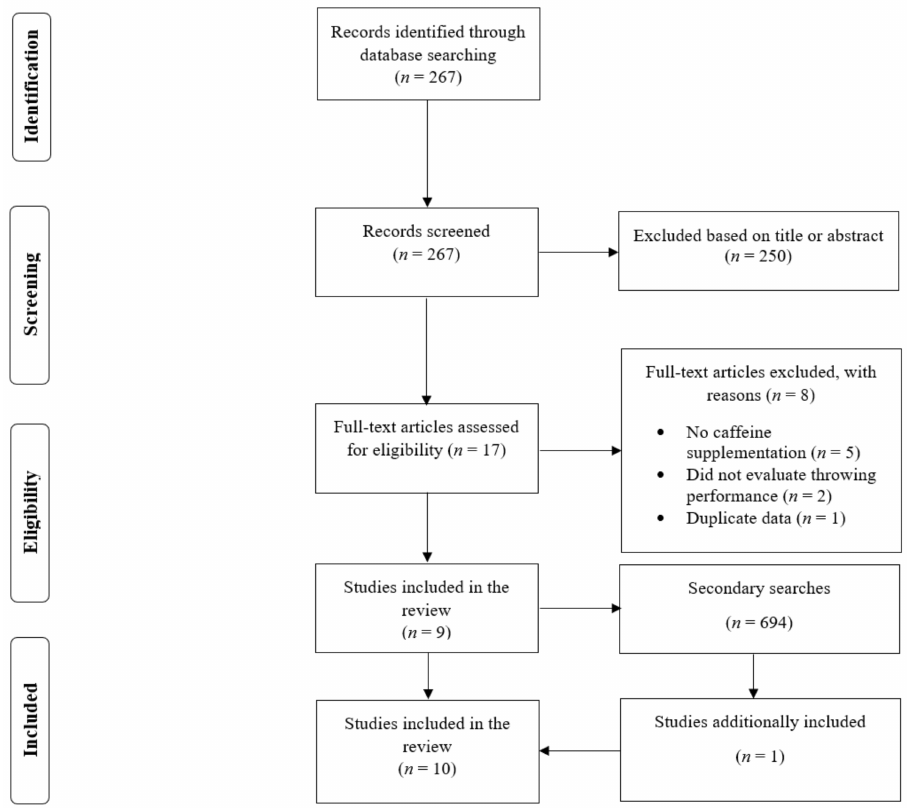
Figure 1. Flow diagram of the search